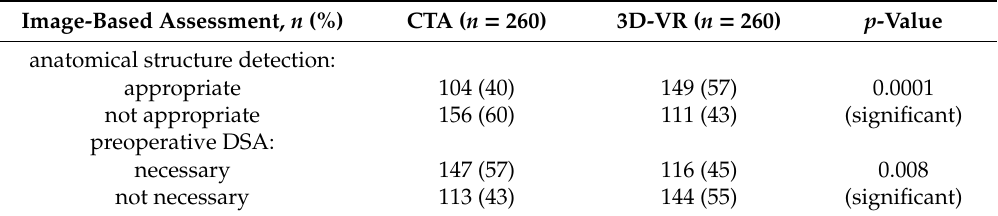
Table 3. Assessment of the anatomical structure detection and preoperative DSA necessity * after presentingconventionalCTAimages(2Dandscreen3D)orreconstructed3D-VRimages, evaluatedusing Fisher’s exact test, assuming a p -value < 0.05 to be